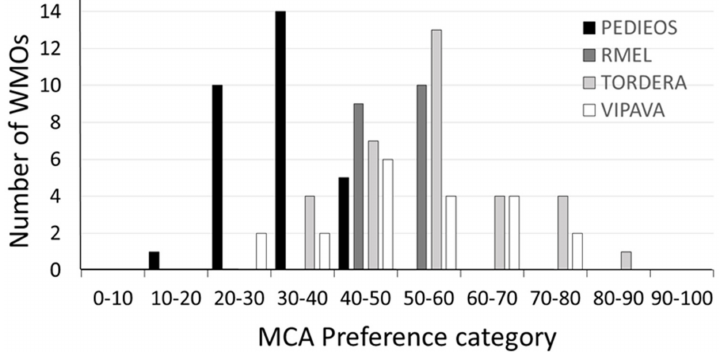
Figure 3. Number of WMOs per preference category taking the characterization and impact assessment